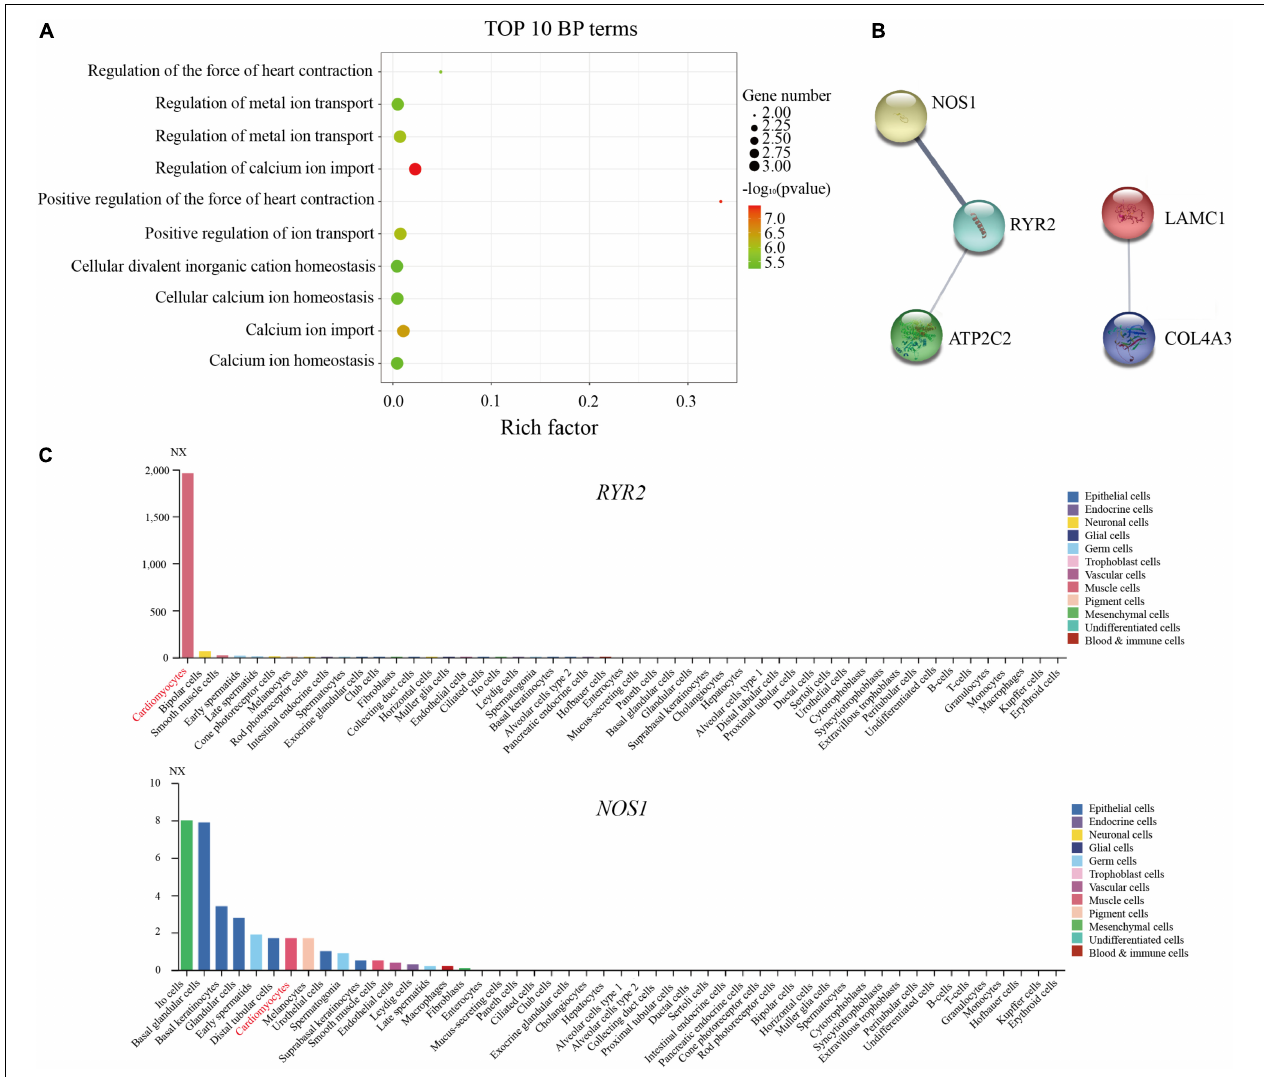
FIGURE 3 | Identification of common pathogenic genes in sporadic and familial atrioventricular nodal reentrant tachycardia. (A) The top 10 biological process terms of five pathogenic genes are depicted using enrichment analysis ( P < 0.05). (B) The protein–protein interactions analysis of five pathogenic genes. (C) The expression of RYR2 and NOS1 was shown in different cell types using the single-cell sequencing